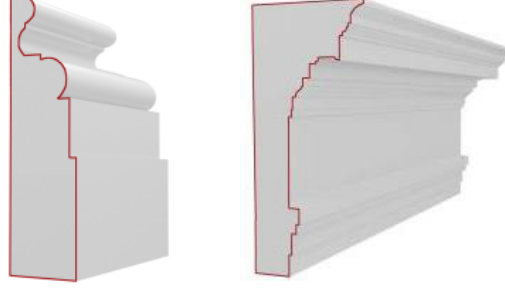
Figure 8. Examples of direct modelling